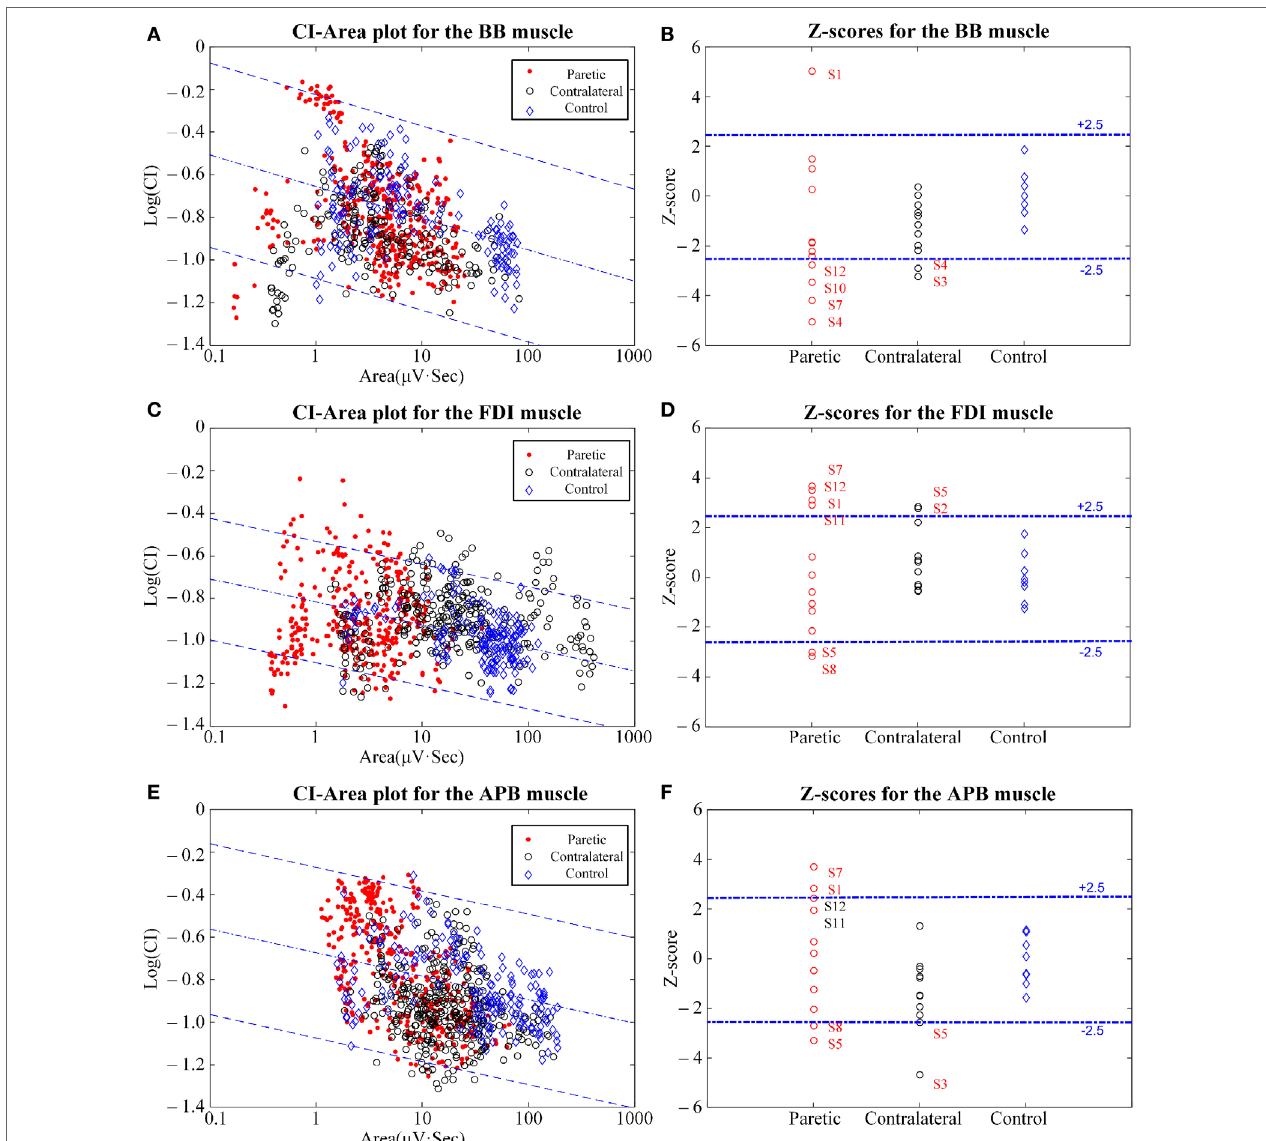
FigUre 2 | The clustering index (CI)-area plot [ (a,c,e) left panel] and the resultant Z -scores [ (b,D,F) right panel] using CI analysis of the biceps brachii (BB) muscle (a,b) , the first dorsal interosseous (FDI) muscle (c,D) , and the abductor pollicis brevis (APB) muscle (e,F) . In the CI-area plots, the red dots represent the paretic muscles, the black circles represent the contralateral muscles, and the blue rhombuses represent the control muscles. In the subplots for the Z -scores, the muscles with Z -scores outside the normal range and some approximating to the normal range are marked with their subject